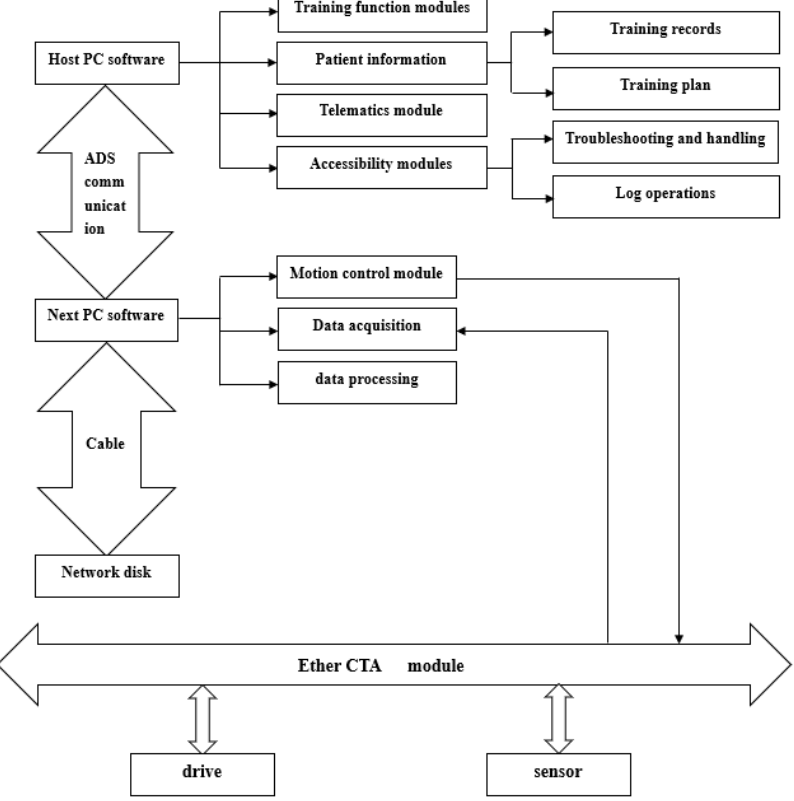
Figure 7. Remote system design of lower limb rehabilitation